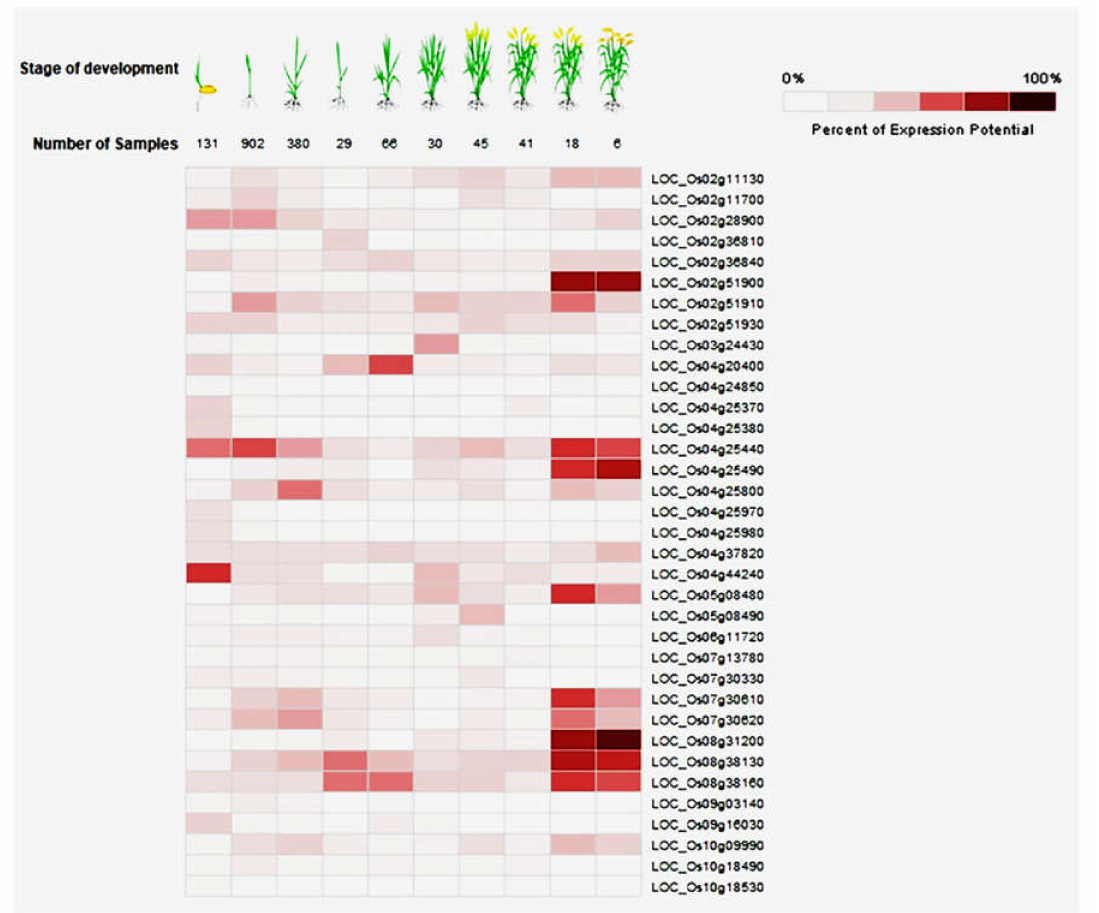
Figure 4. In silico (Genevestigator) deduction of differential expressions of up- and downregu- lated cytokinin-O-glucosyltransferase (CGT) genes of rice during different developmental stages. Downregulation is indicated by white colour and up-regulation by brown